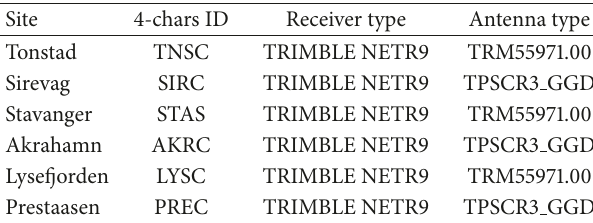
Table 1: Subnetwork reference receivers’ characteristics.